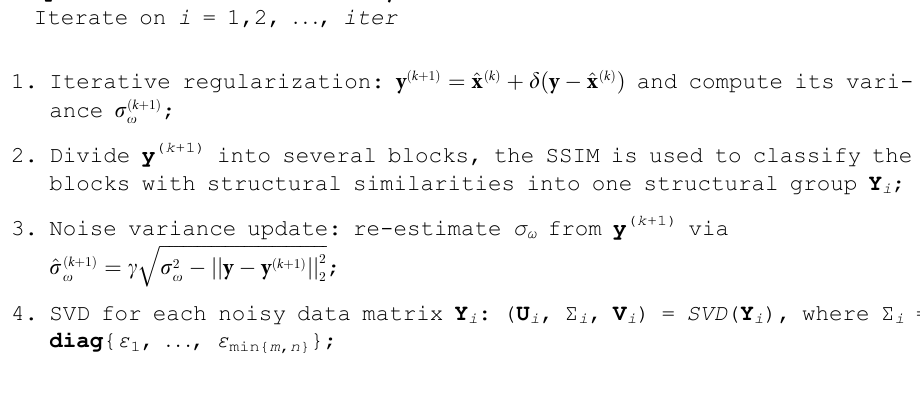
Algorithm 1 Image Denoising via SAFPI